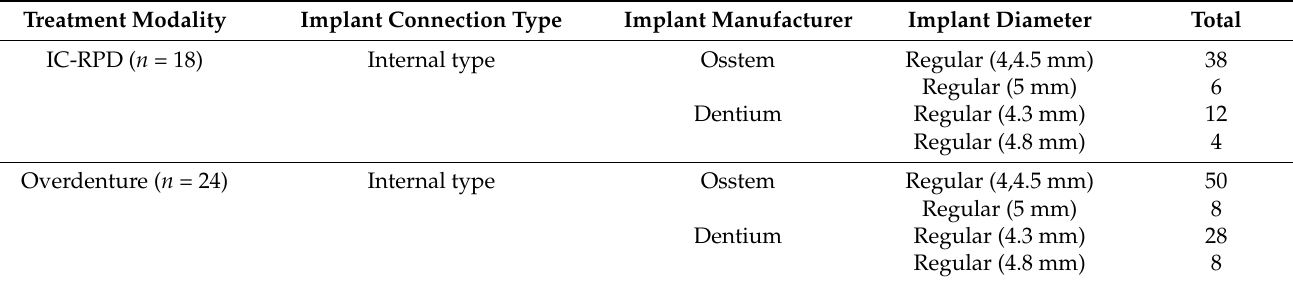
Table 2. The number of implants for IC-RPD and IOD and related